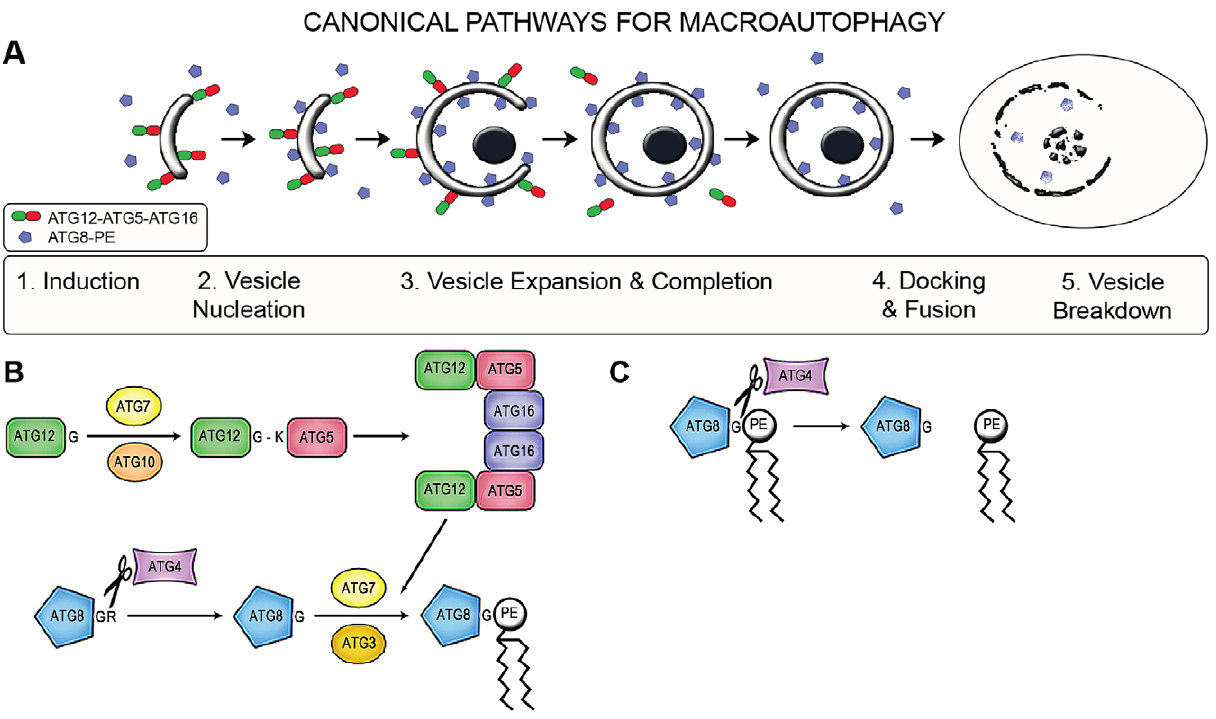
Figure 1. Canonical pathways of macroautophagy. (A) Autophagosome biogenesis and fate. The successive events during the generation of autophagosmes are depicted, from induction to breakdown. The involvement of ATG5, ATG12 and ATG8 and the two conjugation pathways, and the sequence in which they act, are depicted. (B) The two conjugation pathways involved in autophagosome biogenesis. The ATG12-ATG5-ATG16 complex formed in the first pathway is involved in the attachment of ATG8 to phosphatidylethanolamine (PE) during the second pathway. These processes in Leishmania differ from those of mammals in that the Leishmania ATG12 has an extended C-terminal domain beyond the glycine residue required for conjugation to ATG5, suggesting cleavage is required. In addition, Leishmania possess two ATG4s, which may act at different stages of autophagosome formation. (C) Cleavage of ATG8 from the surface of mature autophagosomes before they fuse with the lysosomal network, showing the second step involving